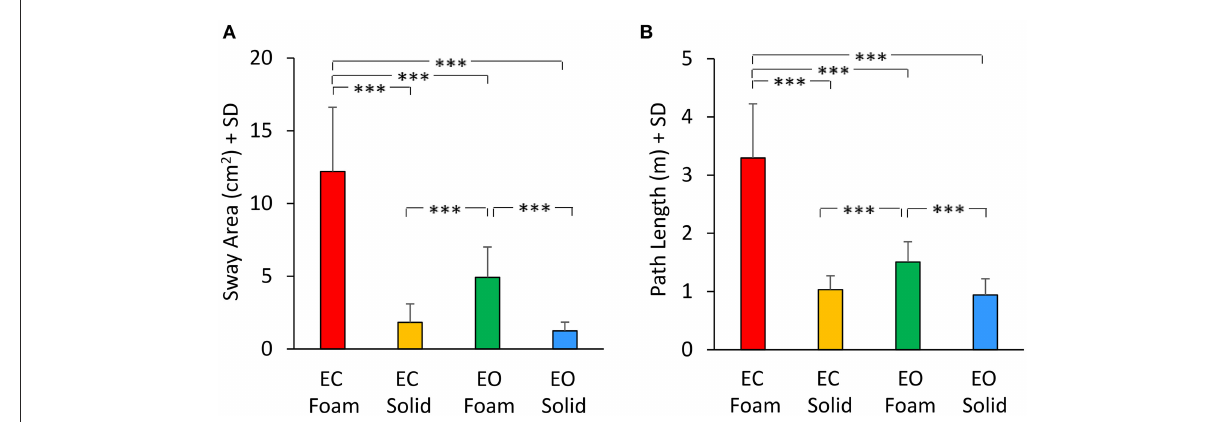
FIGURE7 Geometric measures. Mean values of Sway Area (A) and Path Length (B) for each visual and base of support conditions. Both Sway Area and Path Length were greater with Foam than Solid support. The effect of vision was significant only with Foam. Asterisks indicate significant differences (*** p < 0.001).